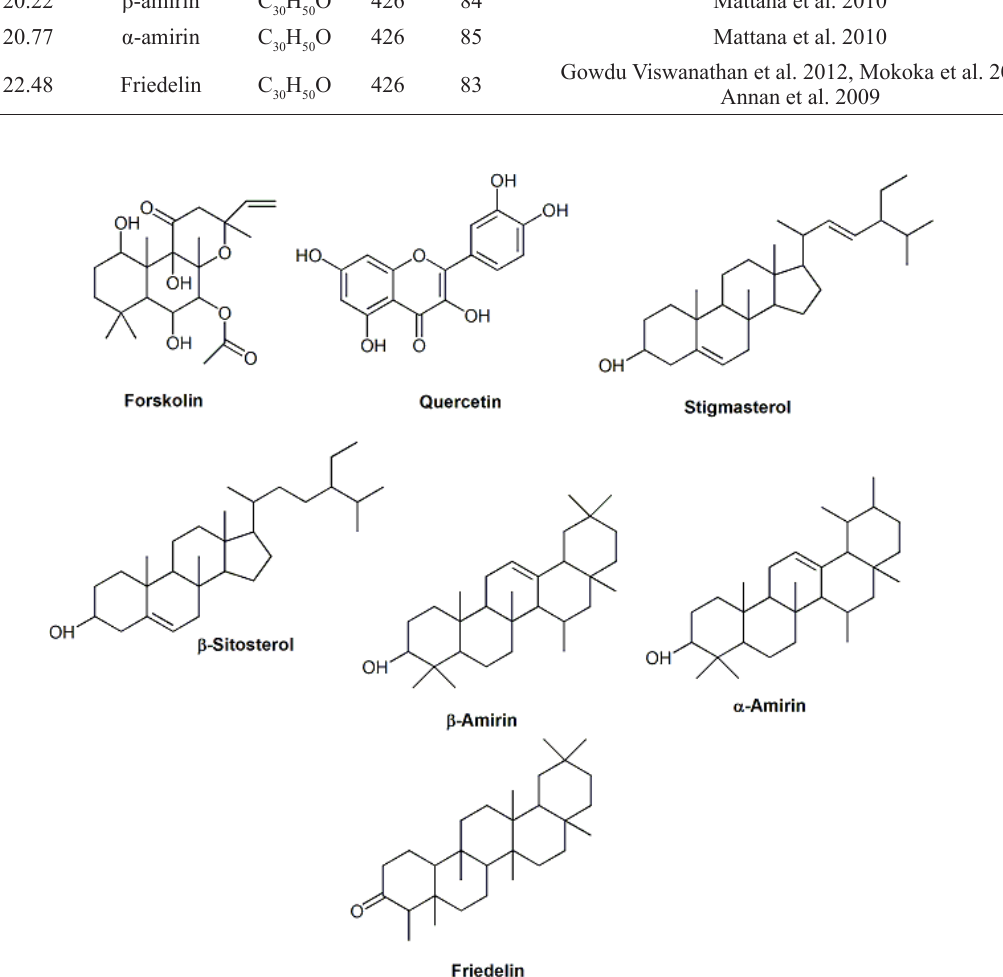
Figure 3 - Compounds identified by GC-MS in dichloromethane extract of P. ornatus